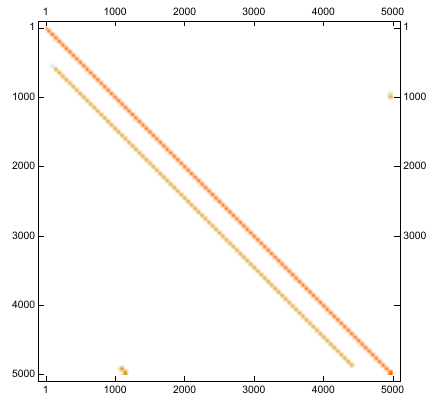
Figure 1. The sparsity pattern of matrices in Test Problem 2.